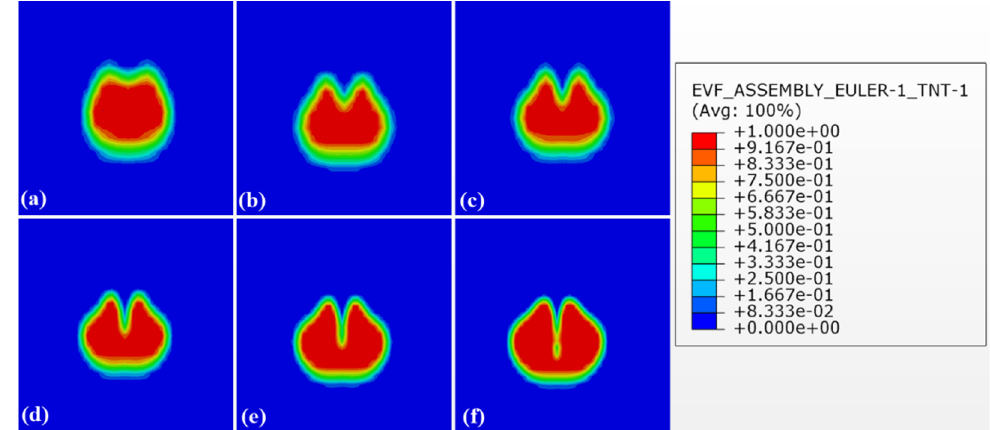
Figure 12. Simulated bubble motion during the collapse phase at: ( a ) t = 5.55 ms; ( b ) t = 5.65 ms; ( c ) t = 5.70 ms; ( d ) t = 5.80 ms; ( e ) t = 5.90 ms; and ( f ) t = 6.10 ms.